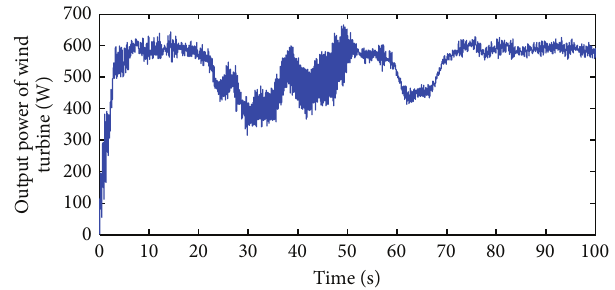
Figure 3: The output power of the 600W wind turbine with turbulent wind of 13m/s.